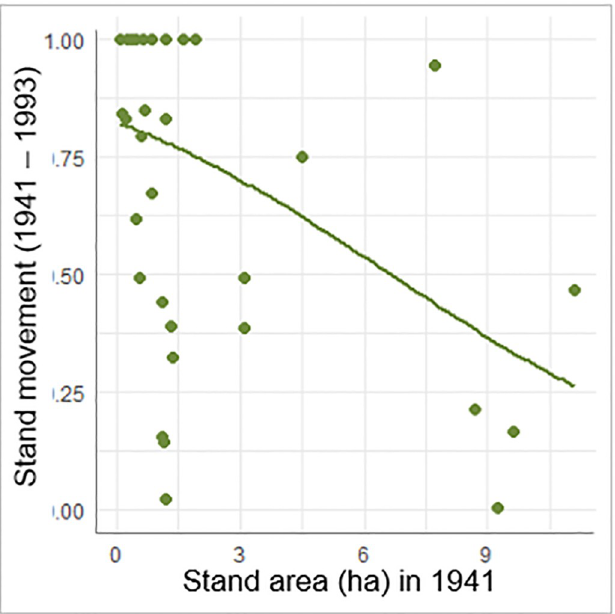
Fig 6. Stand movement from 1941 to 1993 is affected by stand area in 1941. Stand movement on the y-axis represents the portion of a whole stand (1 being the max) that has moved. Plotted dots denote the observed relationship between stand area in 1941 and stand movement between 1941 and 1993. Curve represents expected movement across range of stand areas sampled.